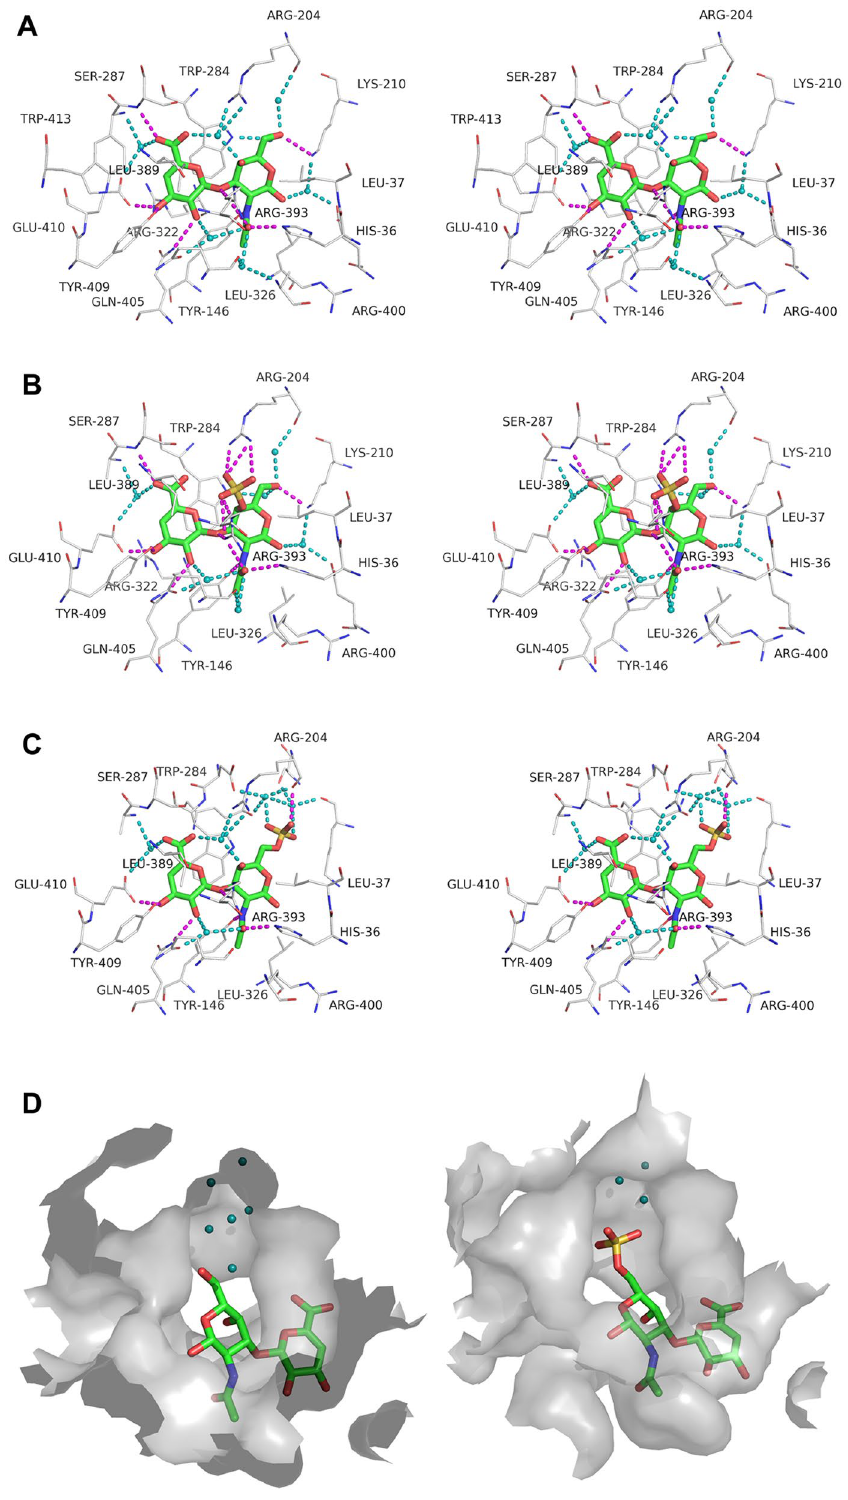
Figure 7. Binding mode of Smon0123 to unsaturated GAG disaccharides. Interactions between Smon0123 and C Δ 0S ( A ), C Δ 4S ( B ), or C Δ 6S ( C ). C Δ 0S, C Δ 4S, and C Δ 6S are shown in sticks (green, carbon atom; red, oxygen atom; blue, nitrogen atom; and yellow, sulfur atom) (stereo-diagram with wall-eyed viewing). Carbon atoms of Smon0123 residues interacting with the substrates are shown in gray lines. Direct and water-mediated hydrogen bonds between Smon0123 and substrates are shown in dashed lines colored with magenta and cyan, respectively. Water molecules (oxygen atoms) are shown as cyan balls. ( D ) Large space for sulfate groups of substrates. In the interaction between Smon0123 and C Δ 0S (left), a number of water molecules are located in the space where a sulfate group of C Δ 6S is accommodated